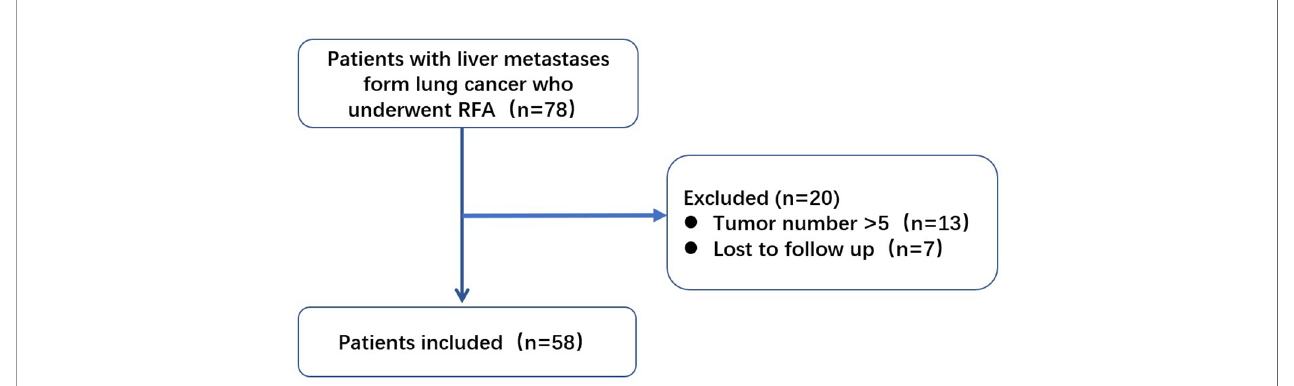
FIGURE 1 | Flow diagram of patient